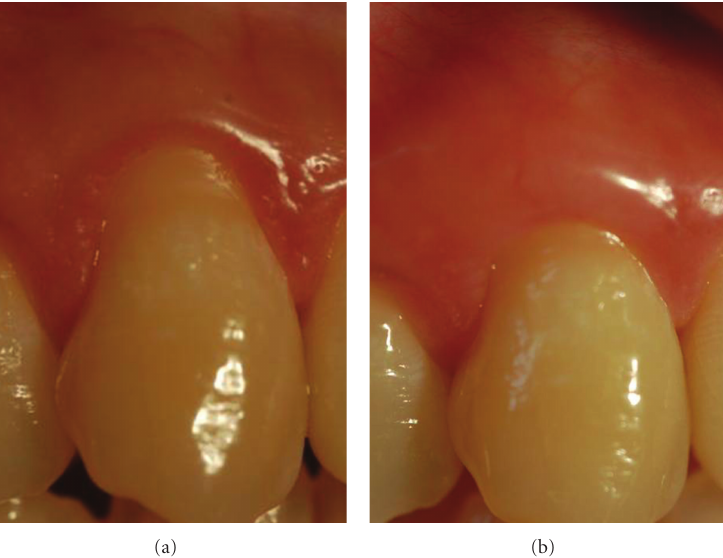
Figure 2: Right maxillary canine (patient #13): (a) before, (b) 3 months after connective tissue graft. The denuded root surface was covered